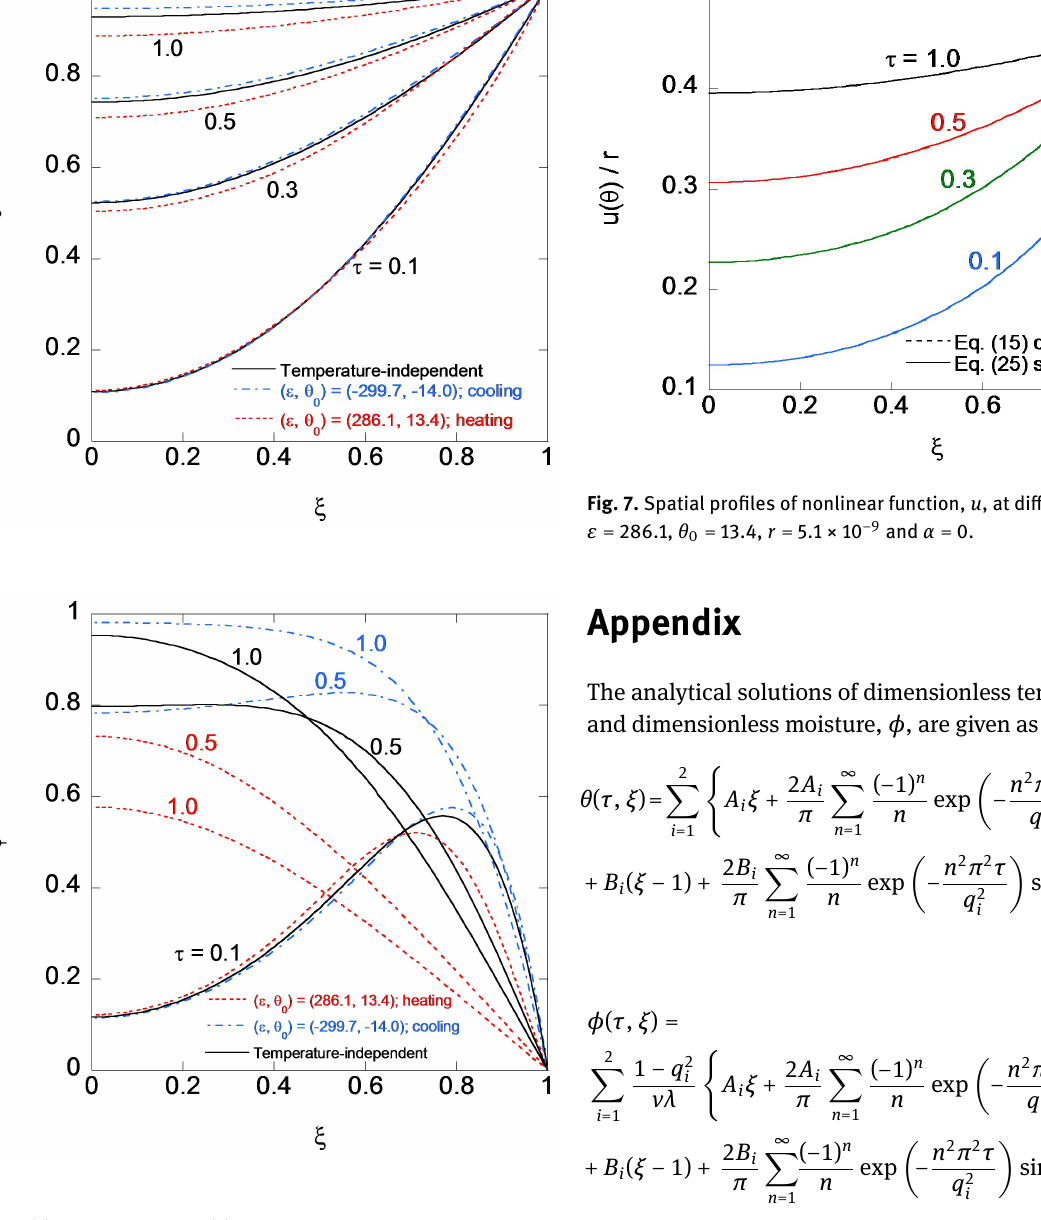
Fig. 6. (A) Temperature and (B) moisture profiles in slab with differ- ent sets of ε and θ 0 for r = 5.1 × 10 −9 and α = 0.